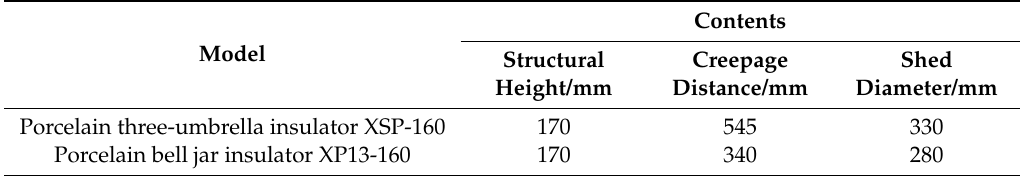
Table 1. The main parameters of the tested